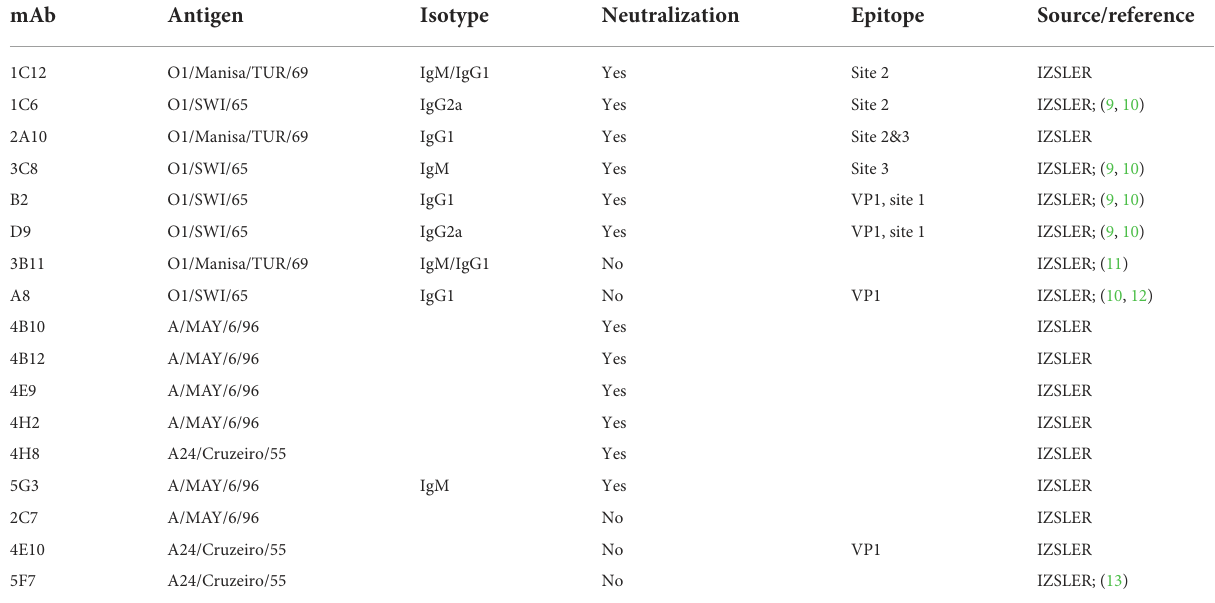
TABLE 1 Monoclonal antibodies.